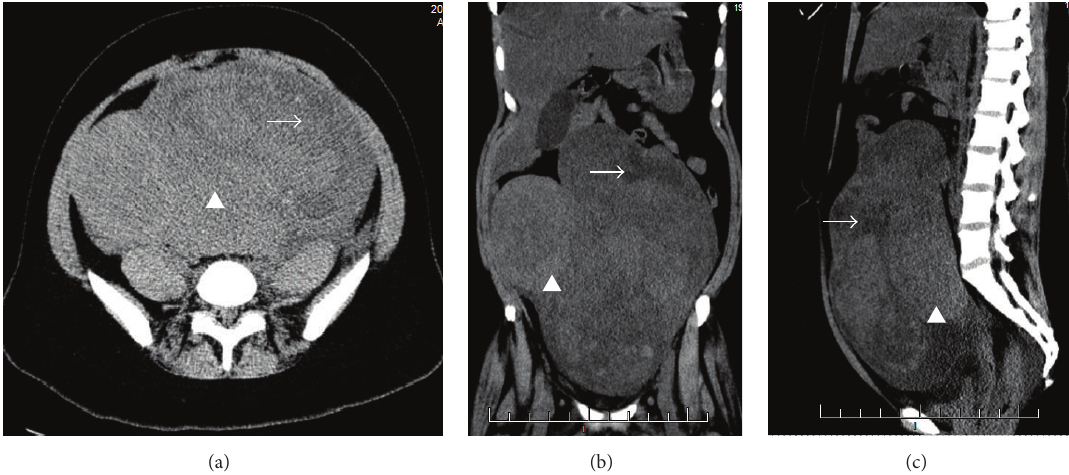
Figure 1: Computed tomography scan of the abdomen and pelvis without contrast showing the pelvic mass with corresponding solid (arrowhead) and cystic components (arrow). Axial (a), coronal (b), and sagittal (c) views.